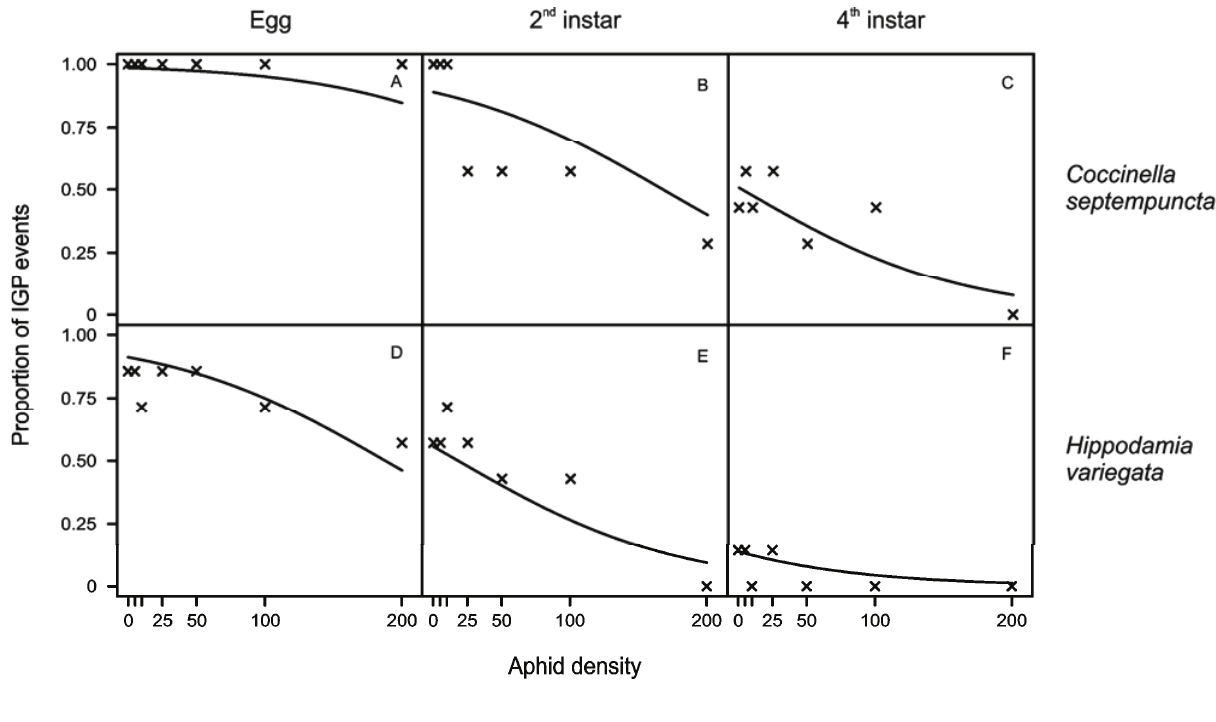
Figure 1. Proportion of IGP events by Coccinella septempunctata L. ( A – C ) and Hippodamia variegata (Goeze) ( D – F ) upon egg ( A , D ), second-instar ( B , E ) and fourth-instar ( C , F ) of the IG-prey at different density of Aphis gossypii Glov. The symbols represent the proportion of the replicates in which IGP occurred, while the line indicates penalized maximum likelihood estimate of the logistic response